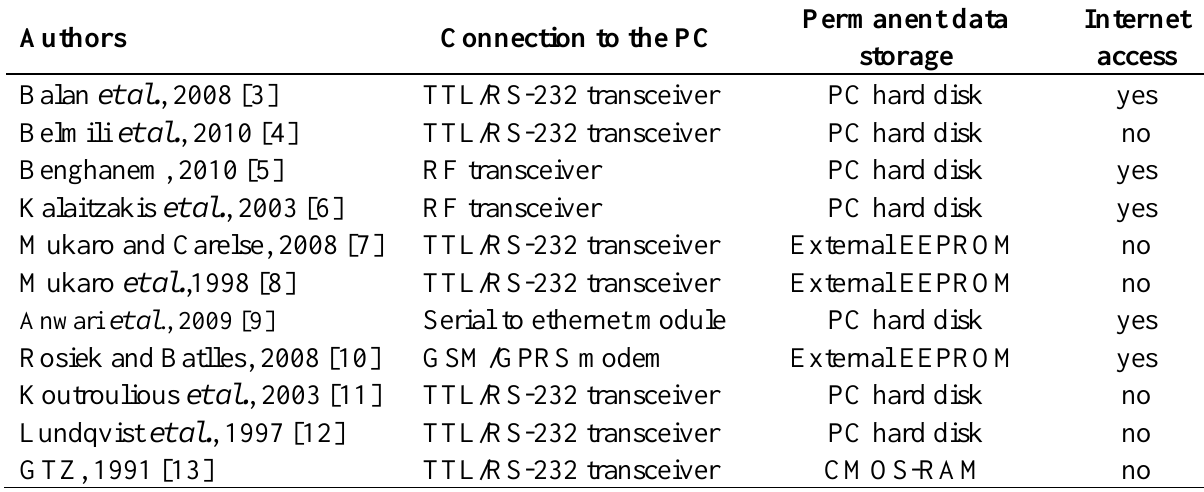
Table 1. Main Characteristics of the Mentioned